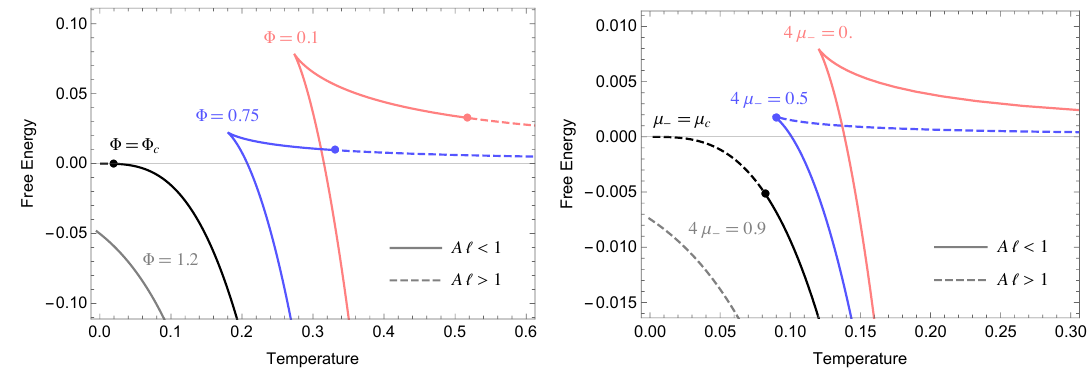
Figure 7 . The Gibbs potential in the grand canonical ensemble as a function of temperature, on the left with 4 (cid:22) (cid:0) = 0 : 3 for varying potential as labelled, and on the right with (cid:8) = 0 : 9 and varying tension as labelled in the plot.